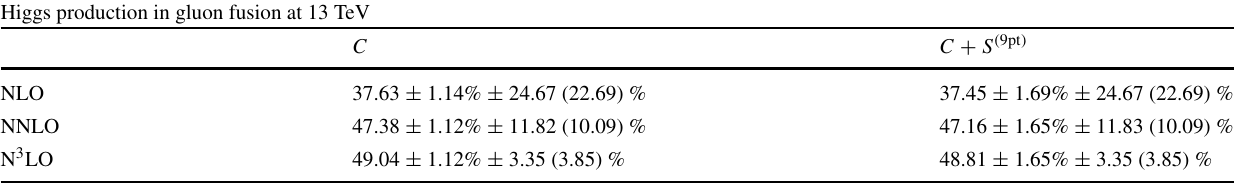
Table 10 Same as Table 9, now for Higgs production in vector boson fusion